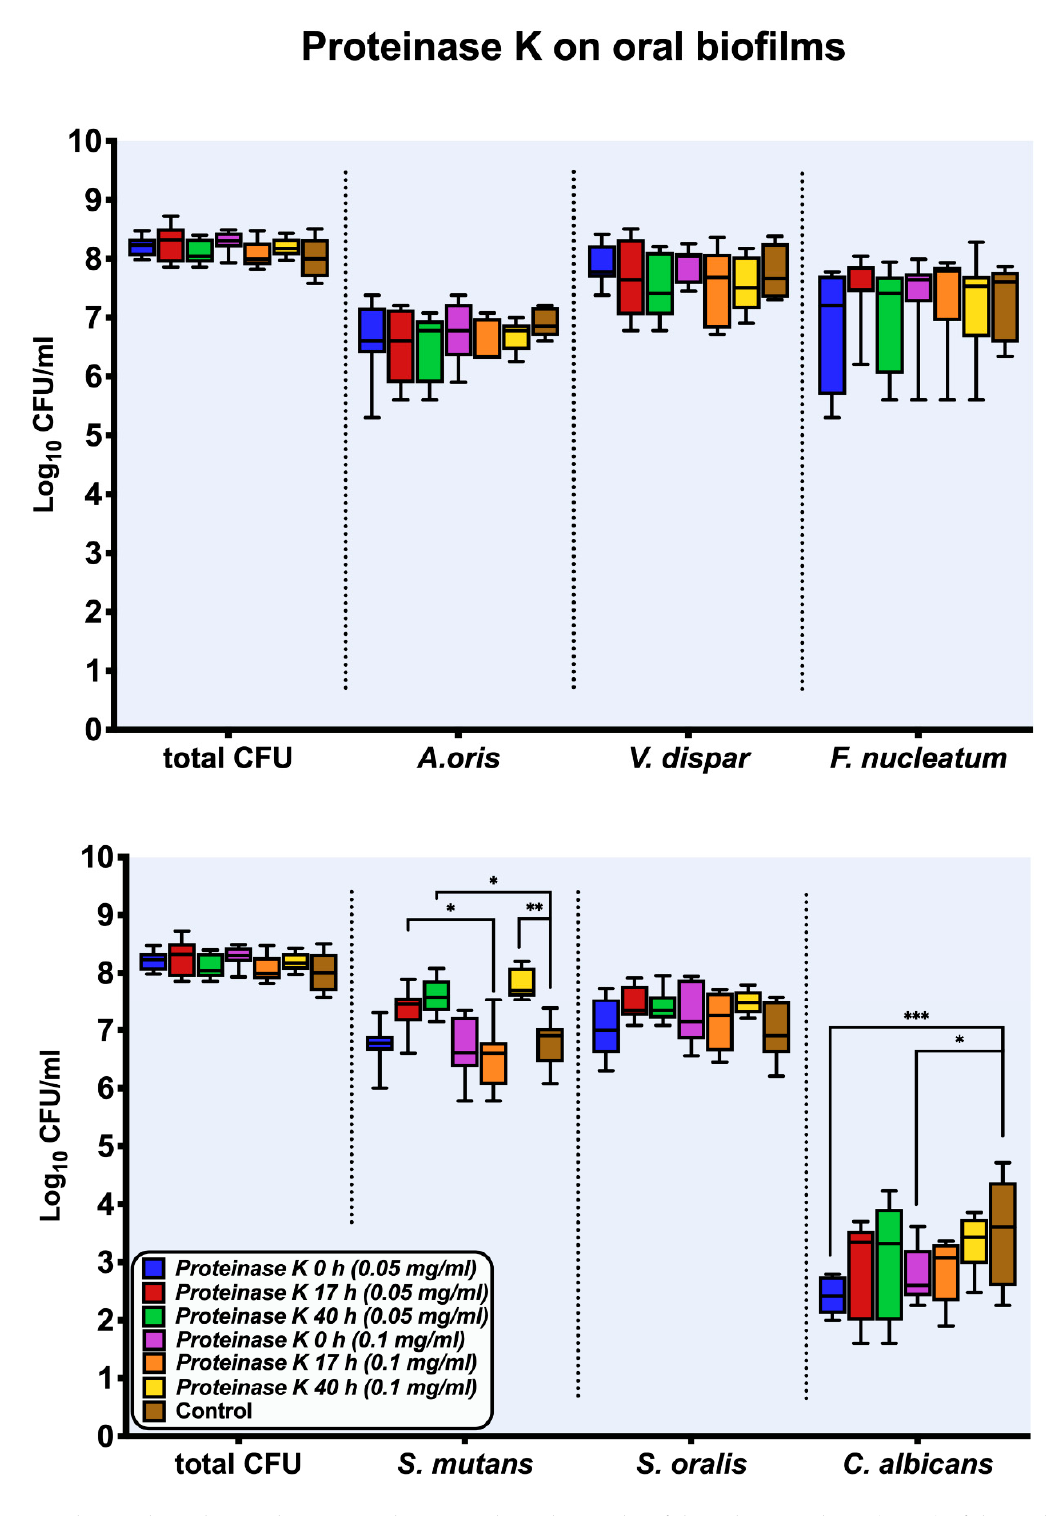
Figure 2. Boxplots with median and interquartile ranges show the results of the culture analyses (CFUs) of the multispecies biofilms after one-hour exposure to proteinase K (0.05 mg/mL, 0.1 mg/mL) at intervals of 0 h, 17 h, and 40 h, respectively. The untreated biofilms are presented as negative controls and CFUs are shown on a log 10 scale per milliliter (Log 10 /mL). Asterisks show statistically significant differences (* p < 0.033, ** p < 0.002, *** p < 0.0002).